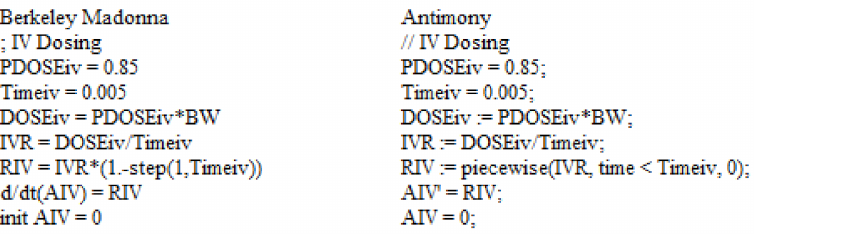
Figure 5. Example code for nanoparticle dosing formulas in Berkeley Madonna and Antimony lan- guages.